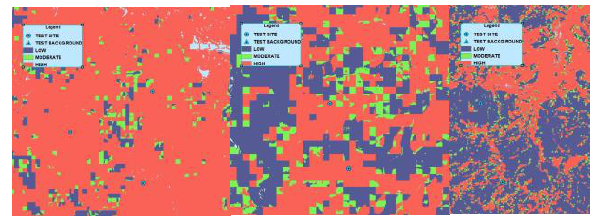
Figure 7. Validation using set of landslide site points and non- site points.